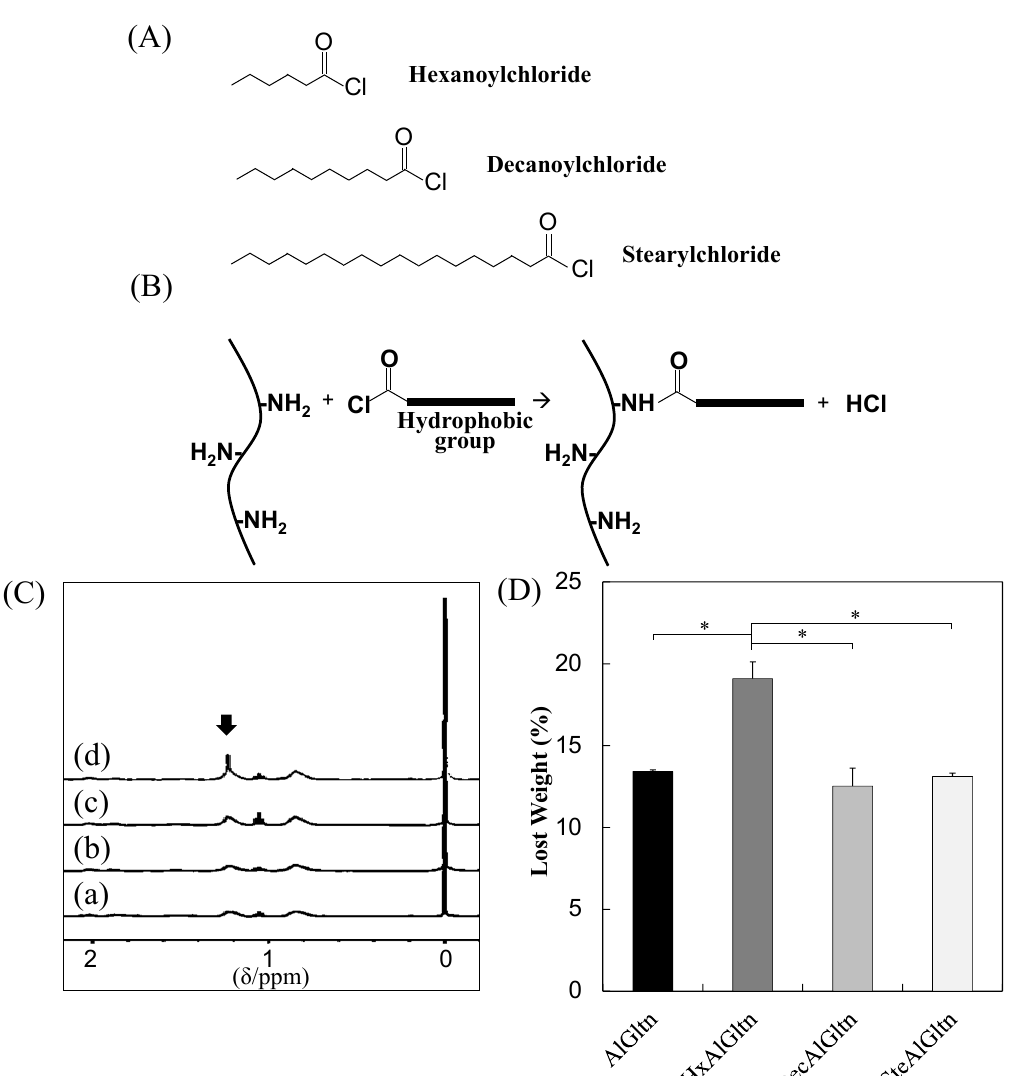
Figure 1. Modification of alkaline-treated gelatin (AlGltns) with hydrophobic groups using fatty acid chlorides and verification of the introduction. ( A ) Chemical formulas of fatty acid chlorides; and ( B ) nucleophilic substitution reaction between an amino group of the AlGltn molecule and a fatty acid chloride; ( C ) H 1 -NMR spectra of (a) AlGltn; (b) 42HxAlGltn; (c) 38DecAlGltn; and (d) 44SteAlGltn (the arrow indicates the peak derived for the methyl group of the alkyl chains); ( D ) Weight loss of hydrophobically modified alkaline-treated gelatin films (hm-AlGltns). Data are shown as the average ± S.D. of three samples (* p <